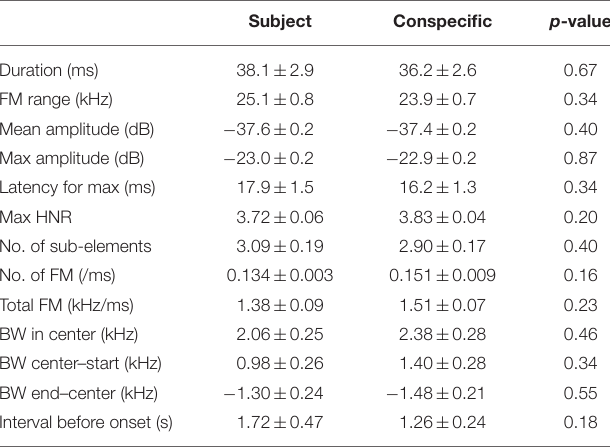
TABLE 2 | Comparisons of mean auditory feature parameters of WFM calls from the subject and the